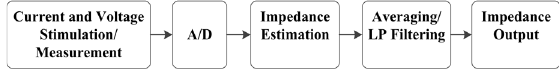
Figure 1: System for acquisition of impedance signals. Current stimulation and measurement could be any method; frequency sweep, multi-sine, or other. Figure 2: Apparent frequencies of a signal with a 0.3 Hz actual